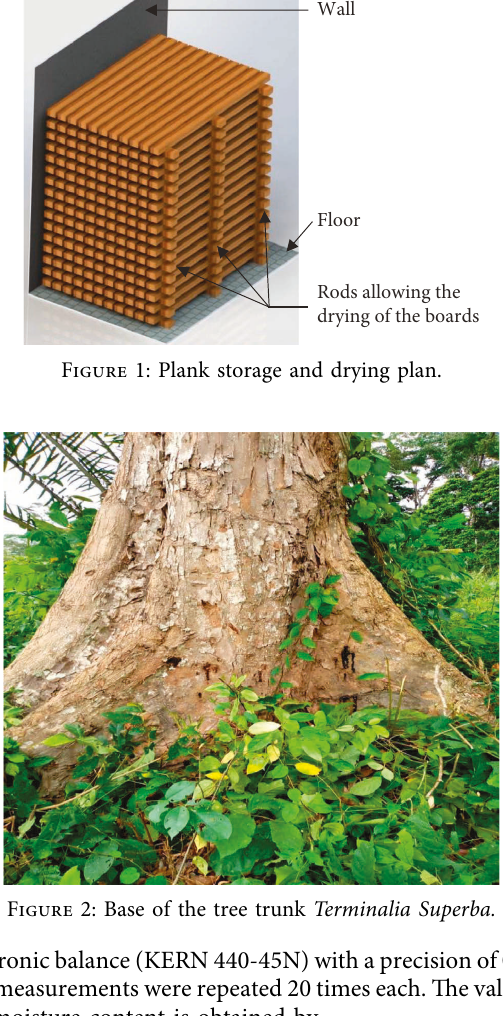
Figure 2: Base of the tree trunk Terminalia